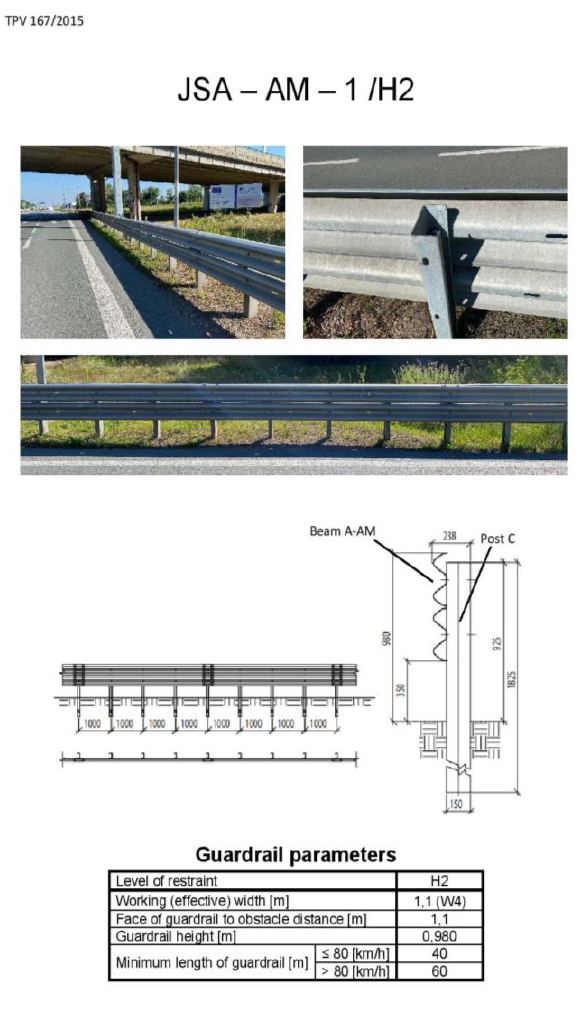
Figure 1 . Example of the catalogue sheet for guardrail JSA – AM – 1 / H2.